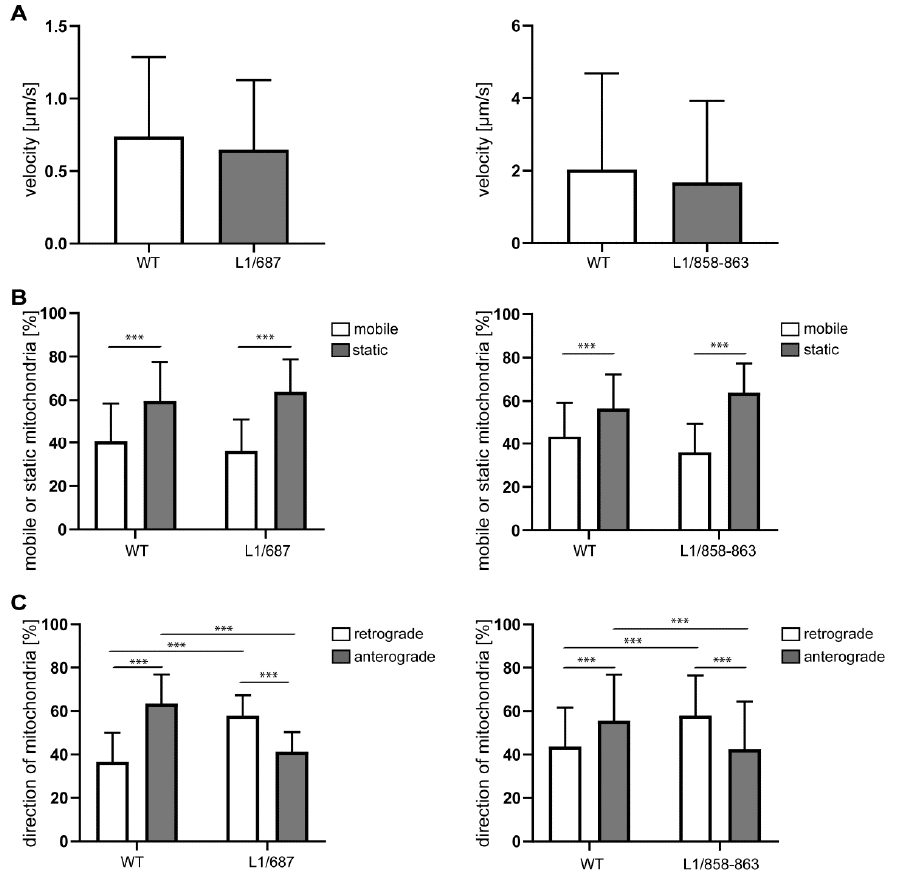
Figure 3. Normal velocity and mobility but enhanced retrograde transport in mitochondria from L1/687 and L1/858-863 mice. Mitochondrial velocity ( A ), mobility ( B ) and transport direction ( C ) were analyzed in cultured cerebellar neurons from 7-day-old male mutants and wild-type littermate mice. Means ± SD from three independent experiments are shown. *** p < 0.005 (velocity: Mann–Whitney test; mobility and direction of L1/868-863: Kruskal–Wallis test with Dunn’s multiple comparison test; mobility and direction of L1/687: two-way ANOVA with Tukey´s post-hoc test).